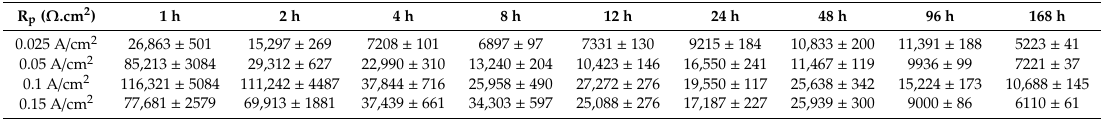
Figure 9. Nyquist diagrams of PEO coatings prepared in the electrolyte with 10 g / L Na 3 PO 4 with different applied current densities after 1 h ( a ) and 168 h ( b ). Table 9. Values of R p of PEO coatings prepared in the electrolyte with 10 g / L Na 3 PO 4 with various applied current densities measured in 0.1 M